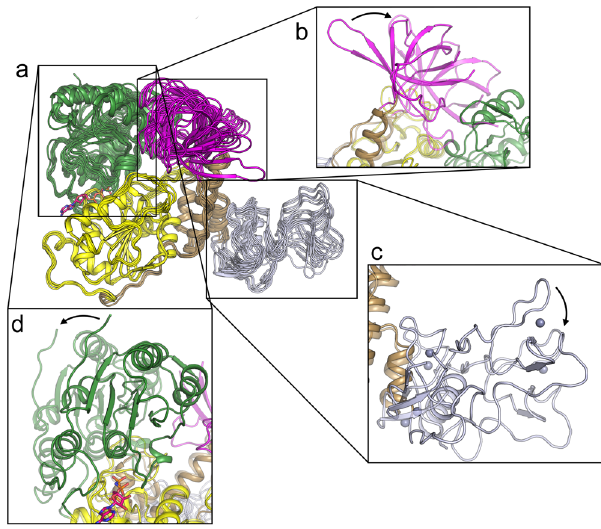
Fig. 2 Conformational fl exibility exhibited in the NSP13 structures. a Overall view showing a structural superposition of the phosphate bound (2 chains), APO (2 chains) and AMP-PNP bound (4 chains) NSP13 structures. The 1A domain was used as the reference for the structural superposition. b Close up view of the variable conformation of the 1B domain, the two most different conformations are shown. c Close-up view of the variable conformation of the Zinc domain. d Close-up view of the variable conformation of the 2A